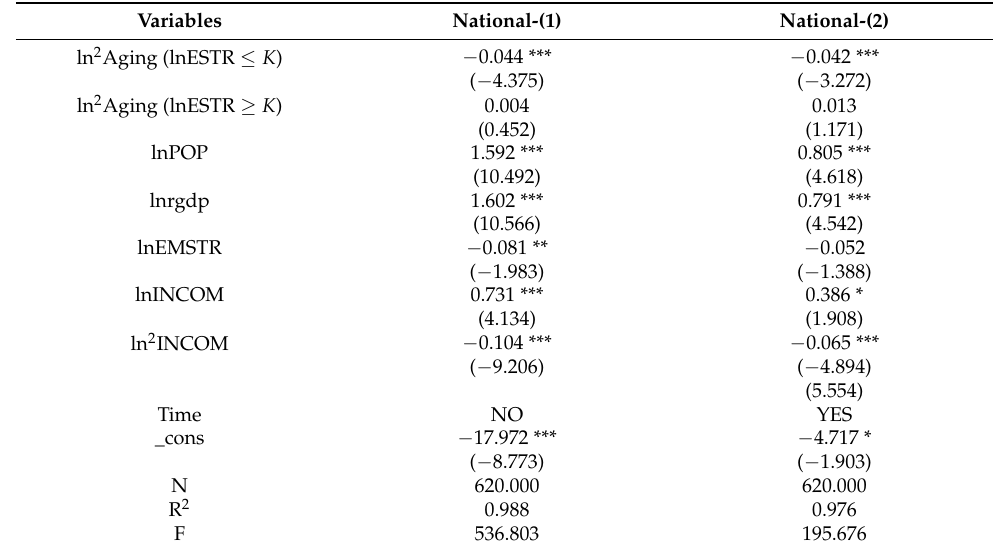
Table 13. The threshold effect of energy consumption structure on the effect of the population aging squared term on carbon emissions.